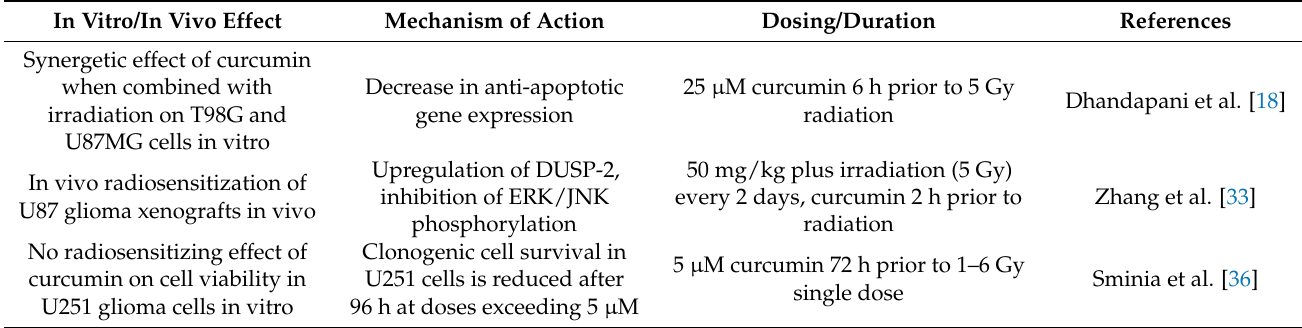
Table 3. Studies on the combinatorial effect of curcumin and irradiation in different in vitro and in vivo GBM models. In Vitro/In Vivo Effect Mechanism of